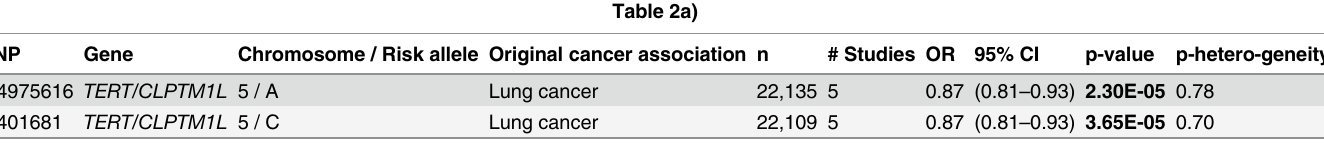
Table 2. Association between cancer GWAS SNPs and